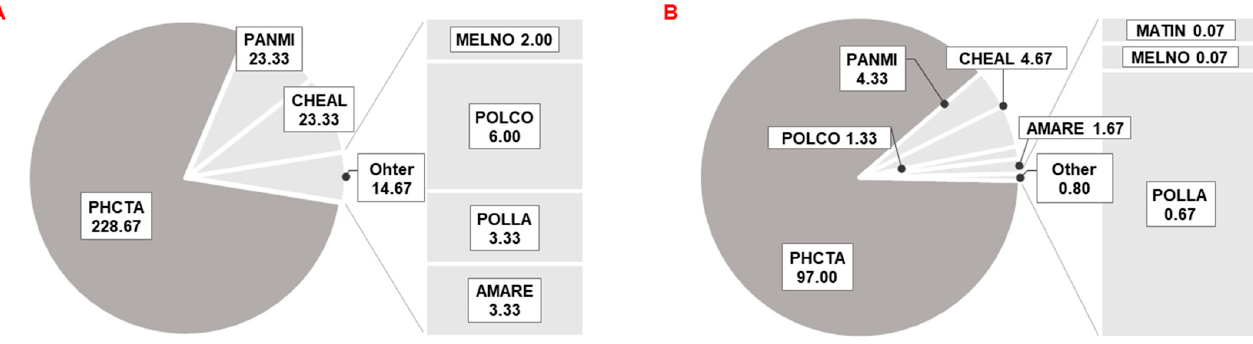
Figure A9. Number of plants per m 2 —Sowing 3 (7th of May) in 2020 ( A ) and leaf coverage in %— Sowing 3 (7th of May) in 2020 ( B ).